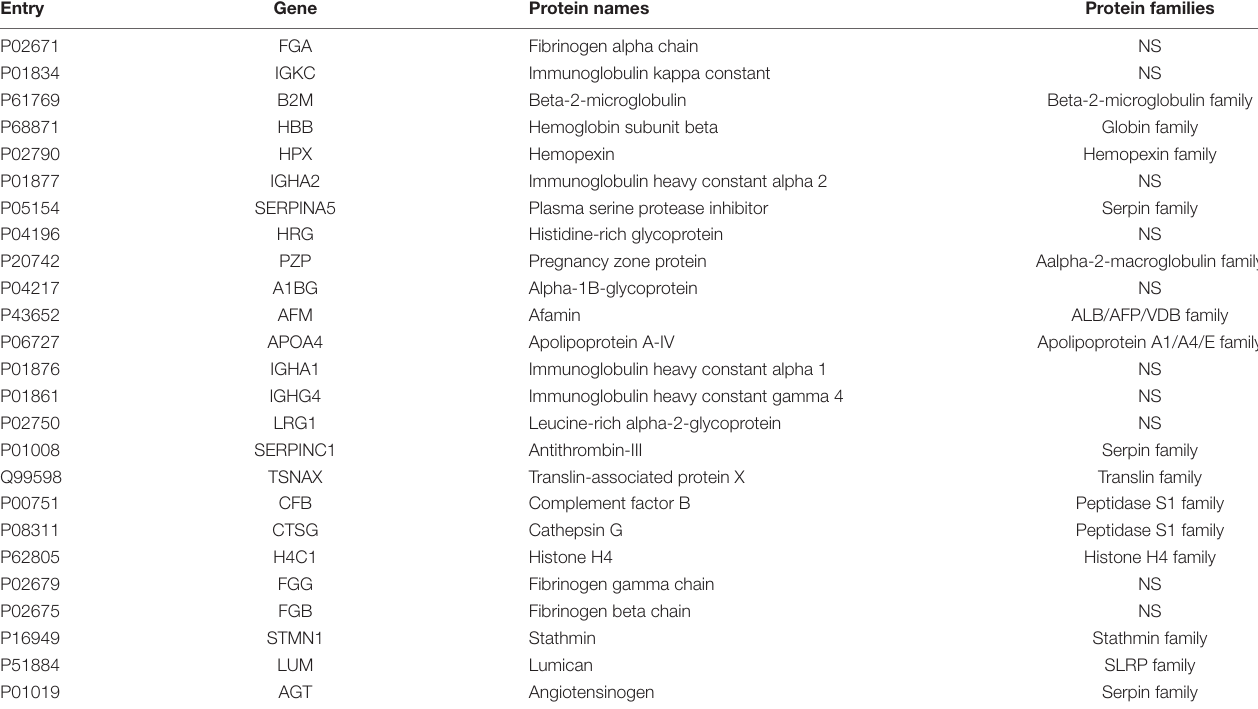
TABLE 3 | Information of 25 DEPs.